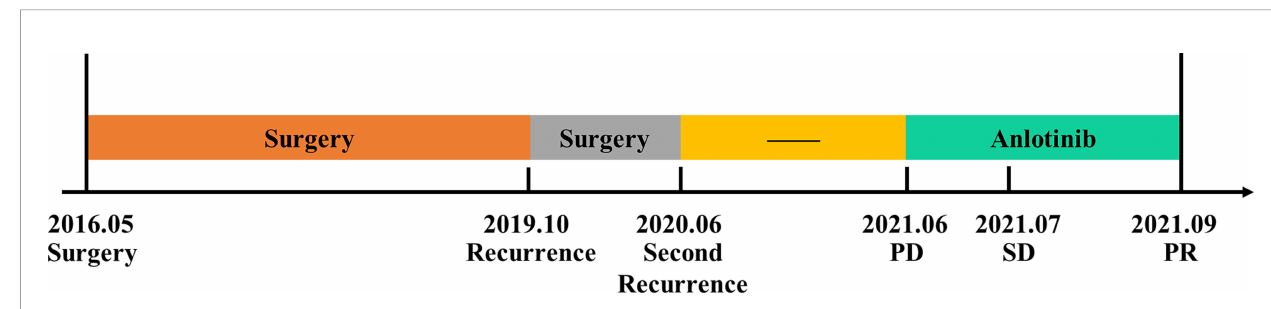
FIGURE 3 | The treatment timeline of the patient with multiple recurrent hemangioblastoma.